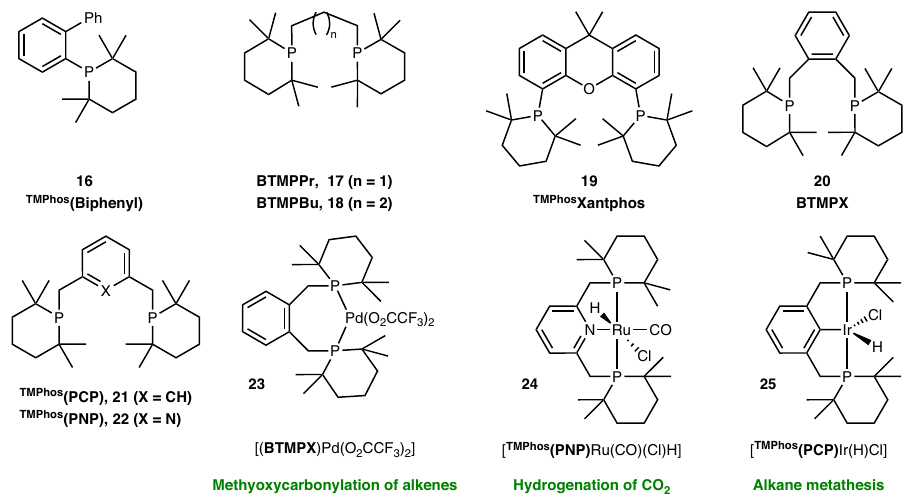
Fig. 7 Ligands and complexes incorporating TMPhos synthons. Ligands incorporating TMPhos ( 16 – 22 ) and associated metal complexes ( 23 – 25 ) with potential catalytic applications (in green).